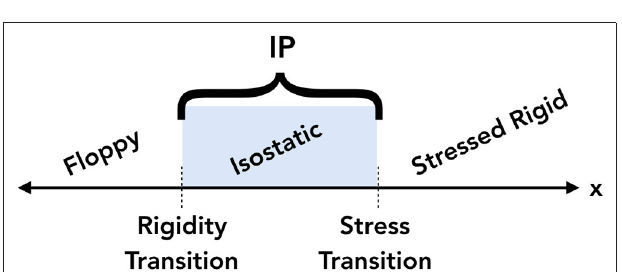
FIGURE 2 | A visual representation of the two thresholds bounding the intermediate phase (IP) for varying compositions, x. The rigidity transition and stress transition separate the floppy, isostatic, and stressed rigid compositions, as